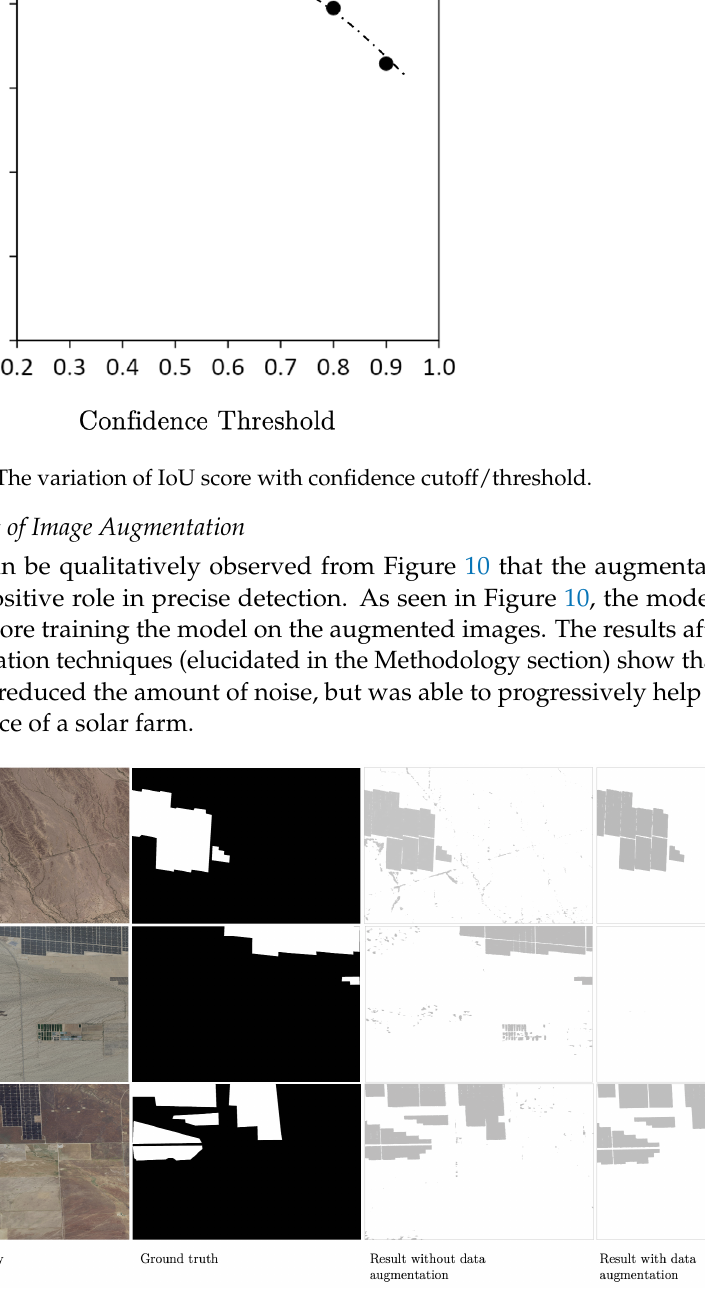
Figure 10. Visualization of early improvement in the model with image and dataset